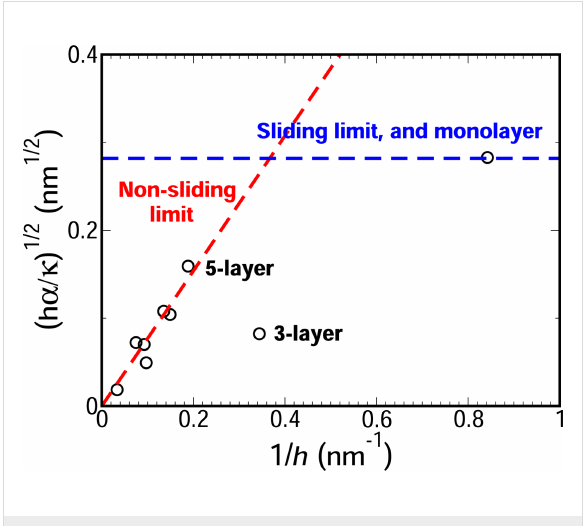
Figure 3: The value of = as a function of 1/ h for the nine measured talc samples. h is a directly measured quantity (see Figure 1), and is obtained from Equation 2 with the measured values of R 0 and h . The red and blue lines correspond, respectively, to the ideal non-sliding ( κ ∝ h 3 ) and sliding ( κ ∝ h ) limits. The values for the thinnest samples (monolayer, three-layers and five-layer talc) are explicitly